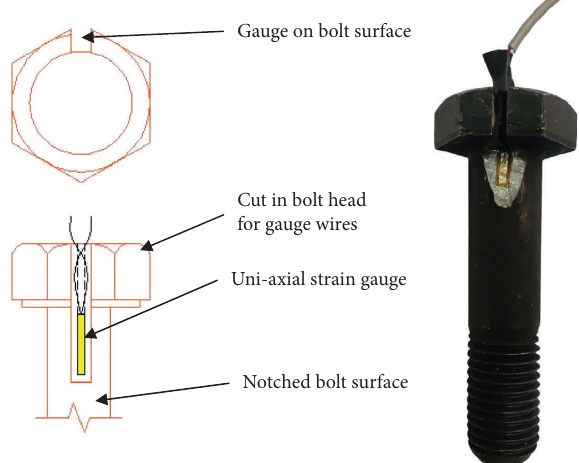
Figure 4: Installation of strain gauges on bolt